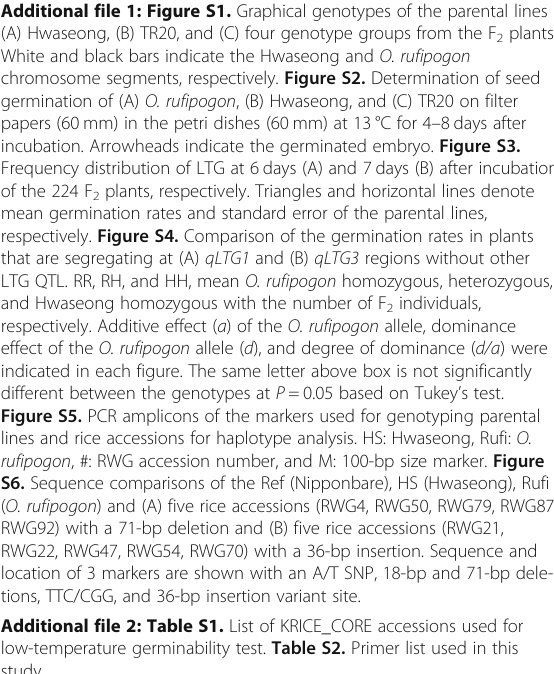
rufipogon , #: RWG accession number, and M: 100-bp size marker. Figure S6. Sequence comparisons of the Ref (Nipponbare), HS (Hwaseong), Rufi ( O. rufipogon ) and (A) five rice accessions (RWG4, RWG50, RWG79, RWG87, RWG92) with a 71-bp deletion and (B) five rice accessions (RWG21, RWG22, RWG47, RWG54, RWG70) with a 36-bp insertion. Sequence and location of 3 markers are shown with an A/T SNP, 18-bp and 71-bp dele- tions, TTC/CGG, and 36-bp insertion variant